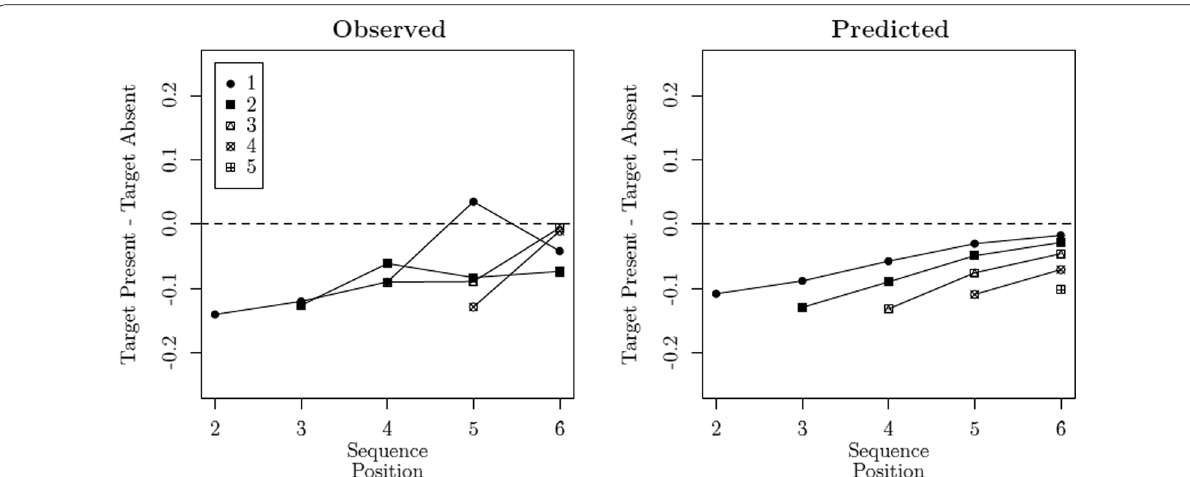
Fig. 7 Differences in the conditional probability of responding “ yes ” to a lure in sequence position i between target-present lineups (in which the target was previously rejected) and target-absent lineups. The different symbols/lines distinguish the preceding position taken by the target in target-present lineups (reanalysis of Wilson et al.,